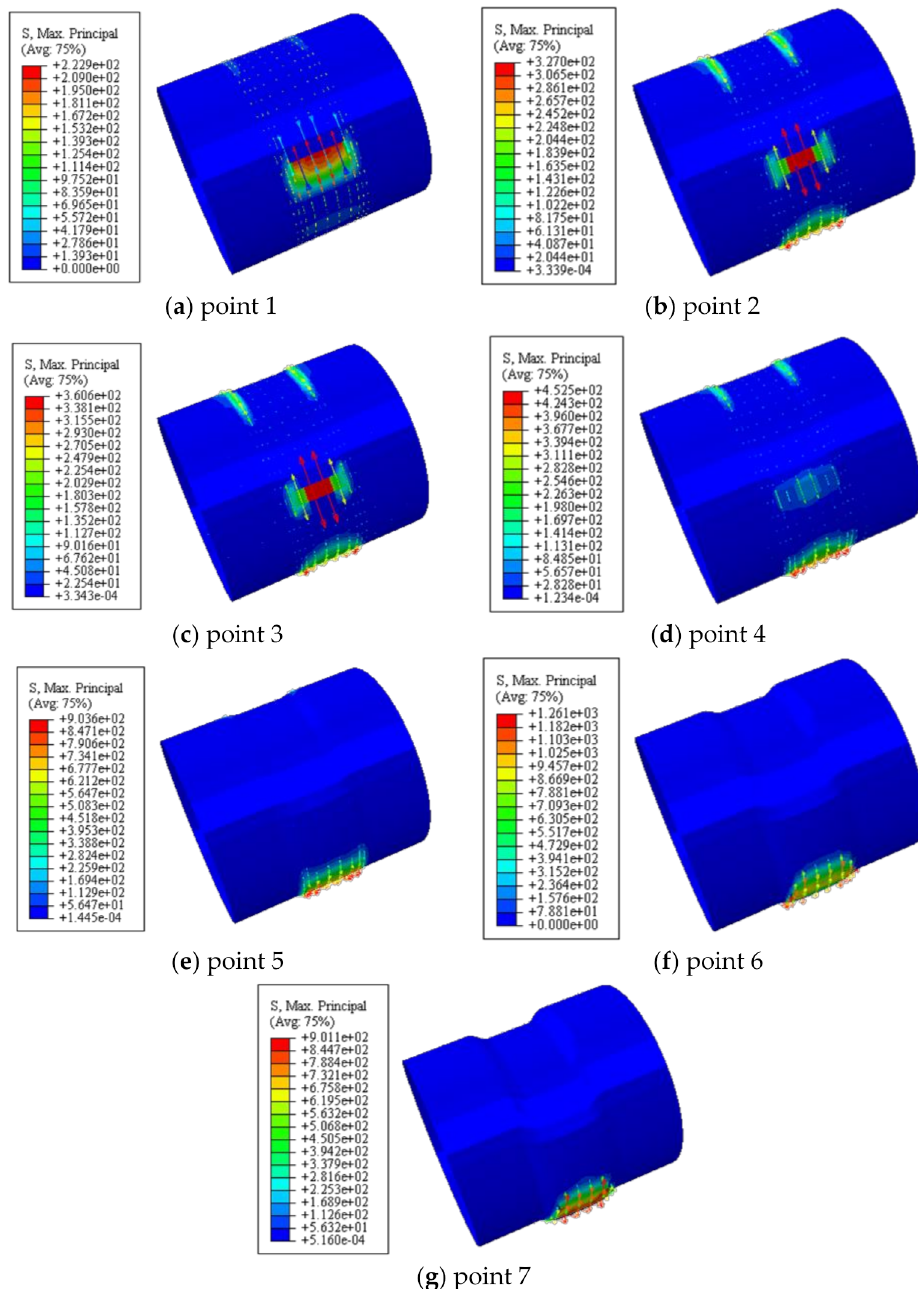
Figure 14. The stress distribution of